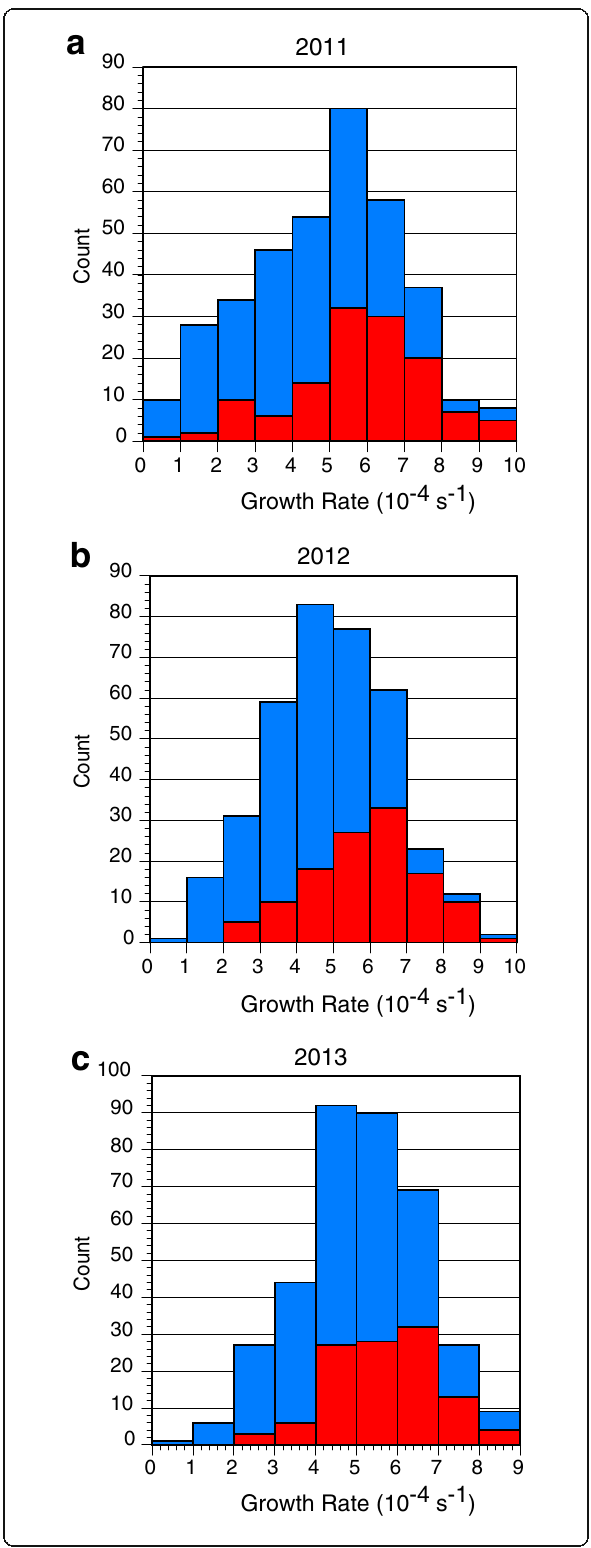
Fig. 3 Histograms of the number of EPS occurrence and non- occurrence days for the R-T growth rate. The histograms indicate the relationship between the number of days of EPB occurrence and non- occurrence and the R-T growth rate in a 2011, b 2012, and c 2013. The values of the R-T growth rate are split into 10 bins with a width of 10 − 4 s − 1 . Red bars are the numbers of days when EPBs are observed, and blue bars are the numbers of days when EPBs are not